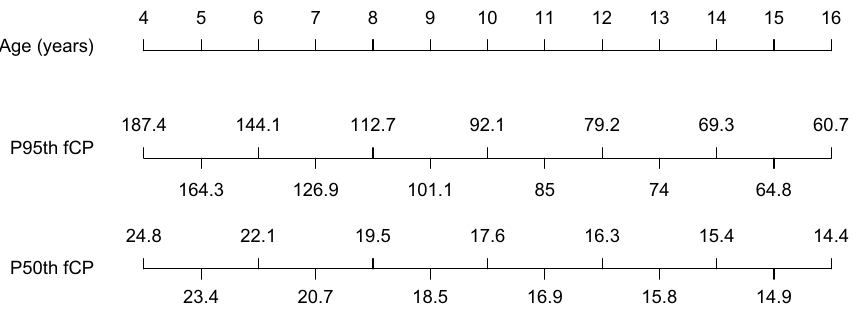
Figure 3. Nomogram of healthy children (4–16 years of age) for the 95th and 50th percentile of fCP levels. ( fCP fecal calprotectin). The nomogram comprises three rows: the first shows the age in years of healthy children from 4 to 16, the second row shows the 95th percentile of the fCP concentrations and the third row, the median of the fCP